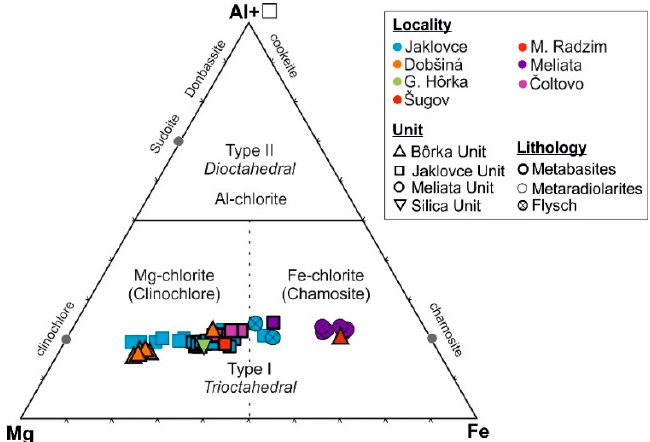
Figure 23. Al + ▢ –Mg–Fe classification diagram of chlorite from the Bôrka, Jaklovce, Meliata and Silica units after [ 115 ].